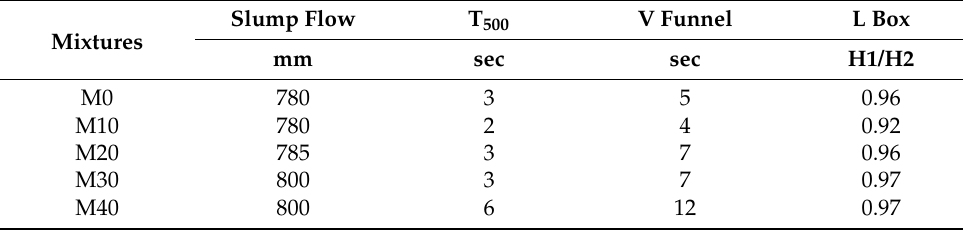
Table 9. Rheological properties of SCC